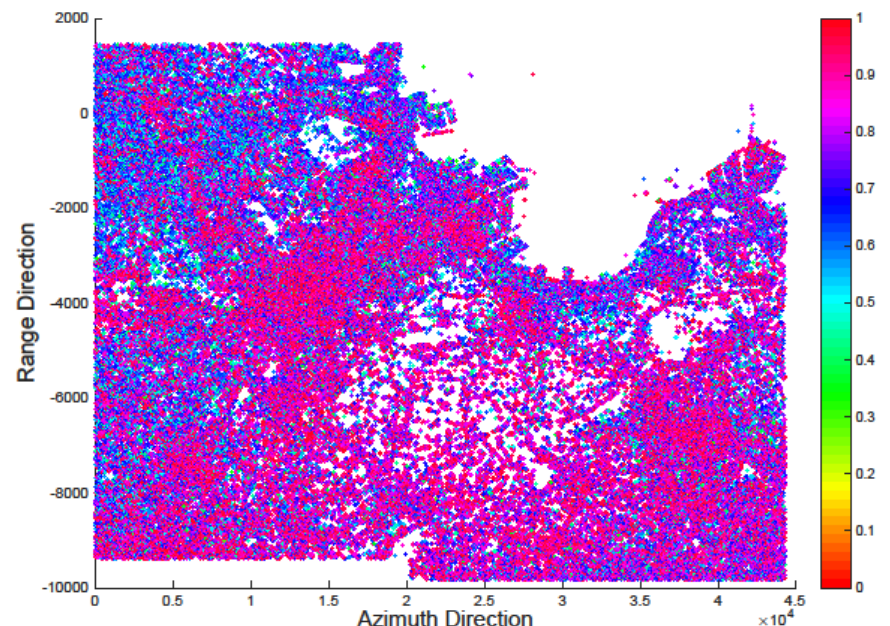
Figure 4. Distribution of the calculated temporal coherence ˆ γ for all of the PS pixels: The X-axis and Y-axis denote the coordinates of PS pixels in the direction of Azimuth and Range, respectively. The color scale shows the temporal correlation ranges from ‘0’ to ‘1’.